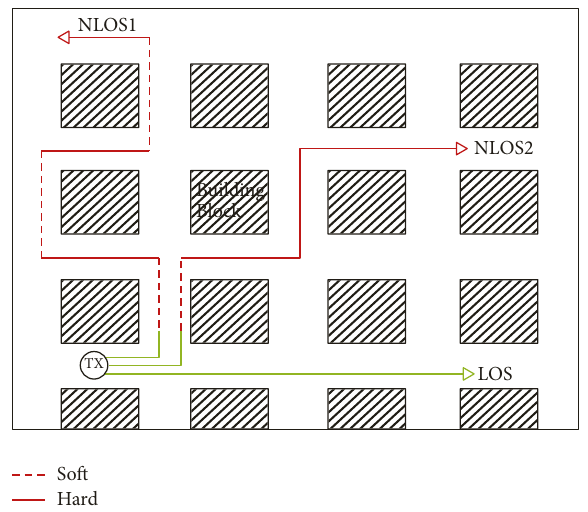
Figure 1: LOS and NLOS routes in street canyon (idealized